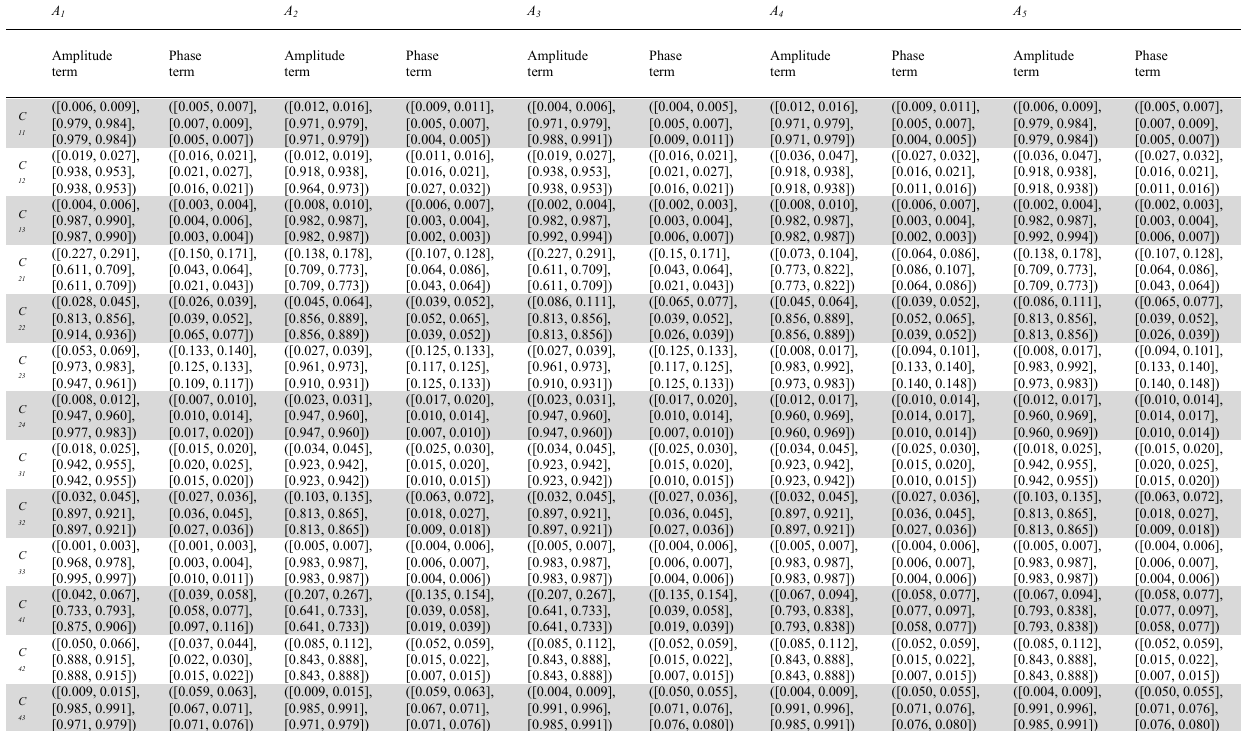
The weight matrix of the attributes in the decision matrix